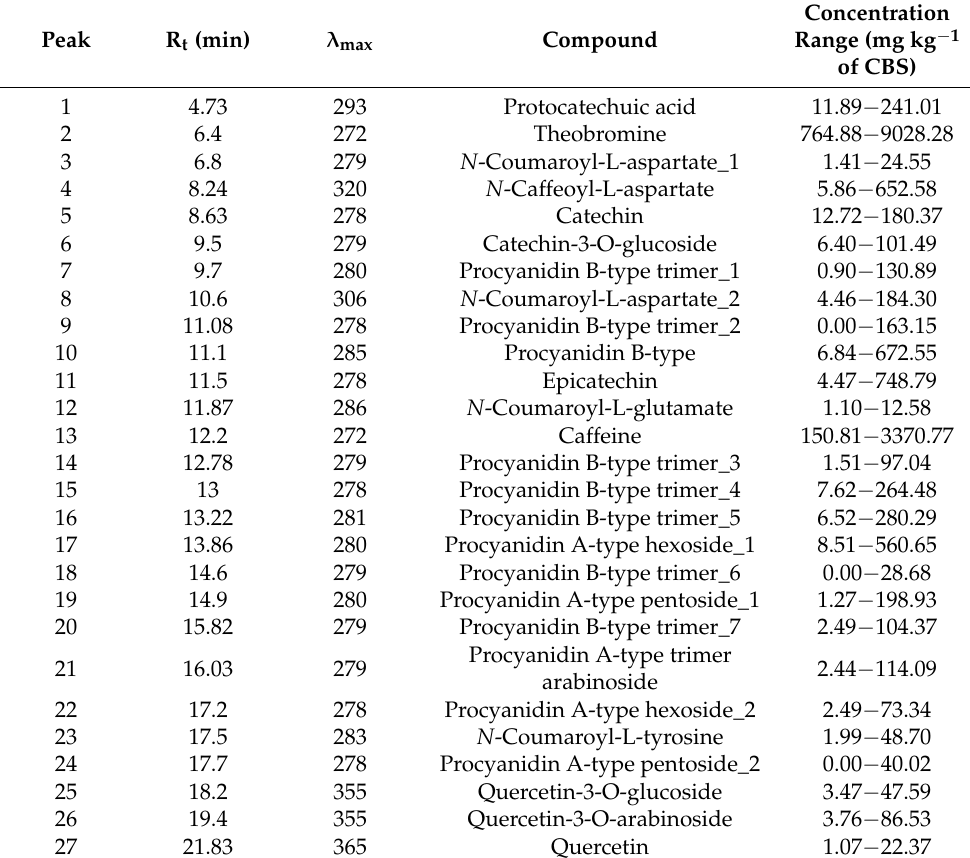
Table 2. Identification and concentration range of polyphenolic compounds and methylxanthines in CBS extracts yielded from roasted cocoa beans from different origins and